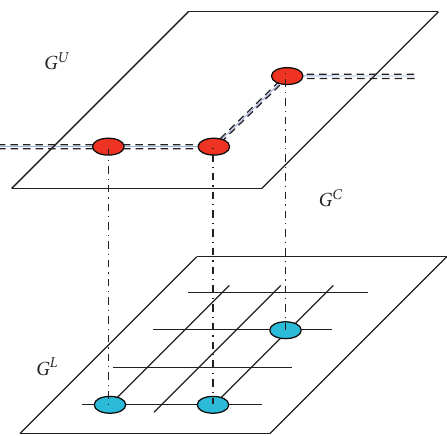
Figure 2: The multilayer network representation